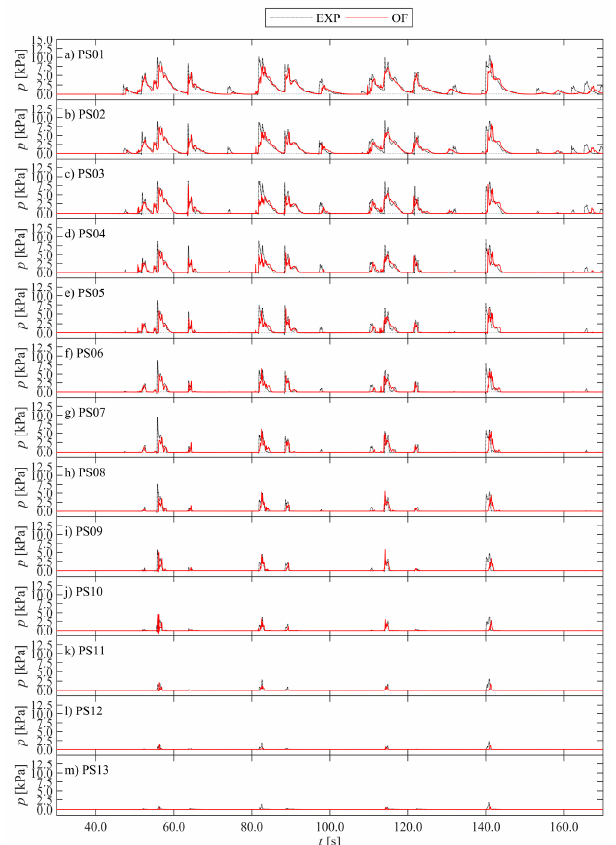
Figure 6. Comparison of F x time series for the vertical wall. The experiment is the LC force Figure6. Comparisonof F x timeseriesfortheverticalwall. TheexperimentistheLCforcemeasurement. measurement.